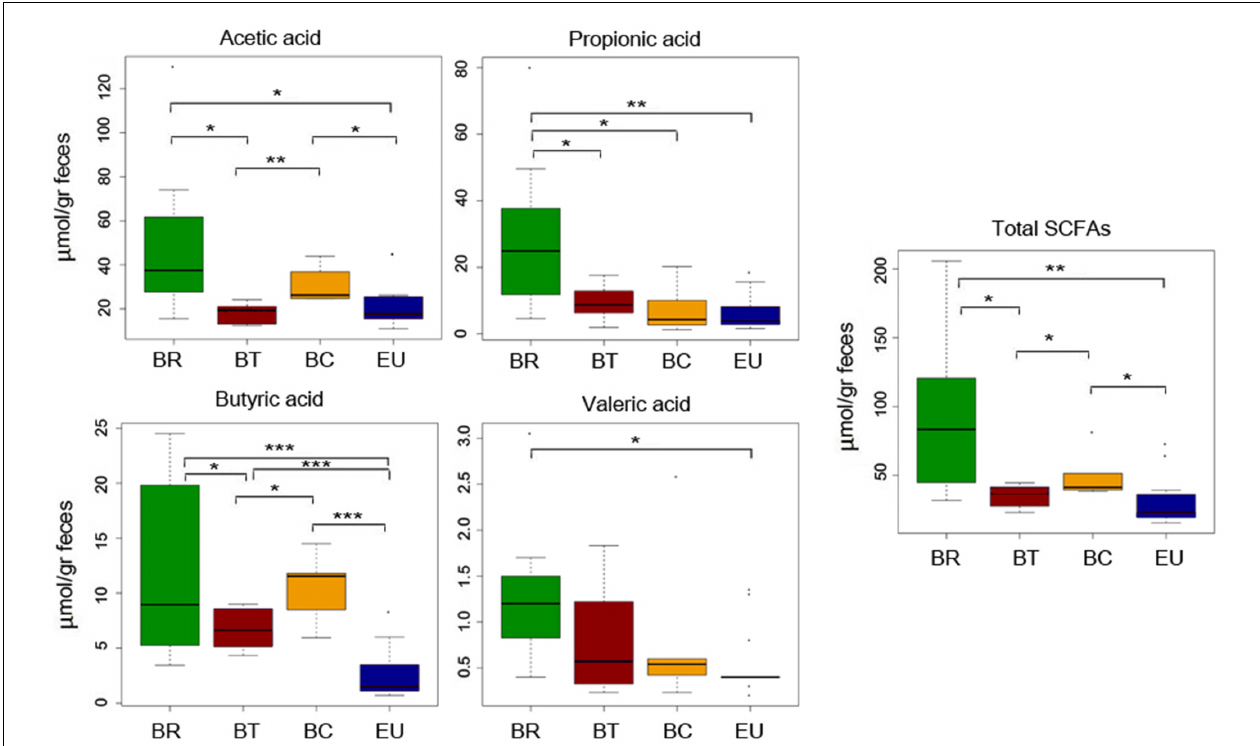
FIGURE 3 | Quantification of SCFAs levels in fecal samples from African and EU populations by SPME-GC-MS. Mean values ( ± SEM) are plotted. Comparison among groups by one-tailed Student’s t -test. ∗ p < 0.05; ∗∗ p ≤ 0.01; ∗∗∗ p ≤